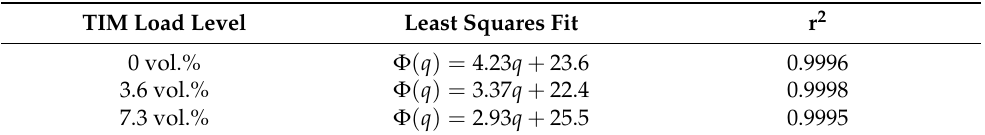
Table 2. Linear dependence of equilibrium temperature ( Φ ) on heat dissipation ( q ) with a fixed intercept at the ambient room temperature at the time of experiment for each TIM loading level TIM Load